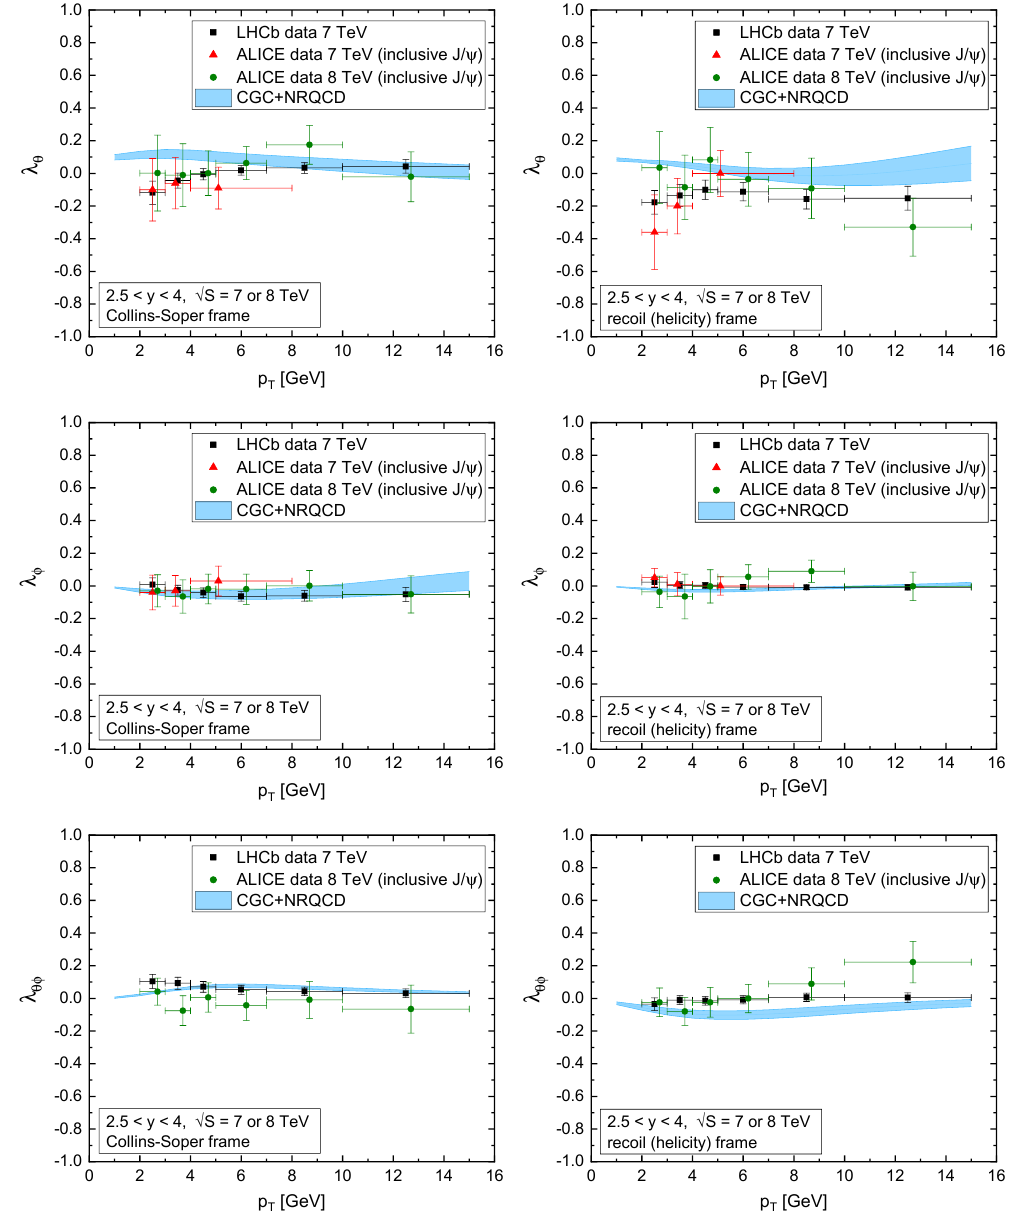
Figure 2 . The angular distribution coe(cid:14)cients (cid:21) (cid:18) ((cid:12)rst row), (cid:21) (cid:30) (second row) and (cid:21) (cid:18)(cid:30) (third row) in the Collins-Soper frame (left column) and in the recoil frame (right column) as functions of the J= the ALICE data are for inclusive J= production, containing contributions from B -meson